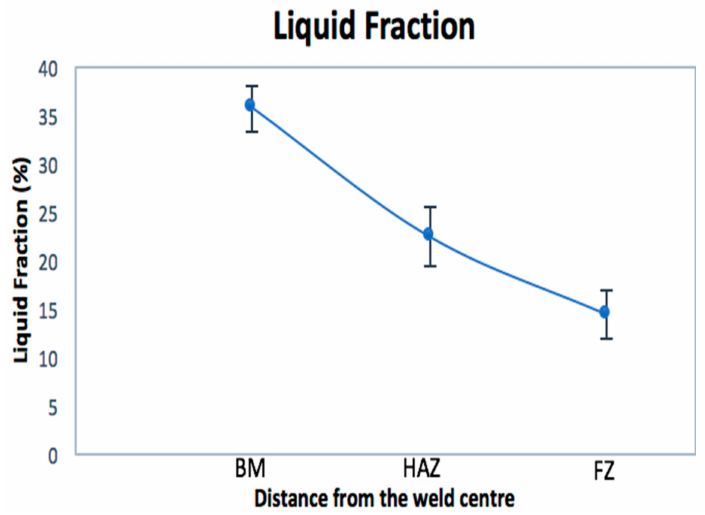
Figure 7. Liquid fraction against distance from the centre of the weld for Al 7075 alloy EB welded